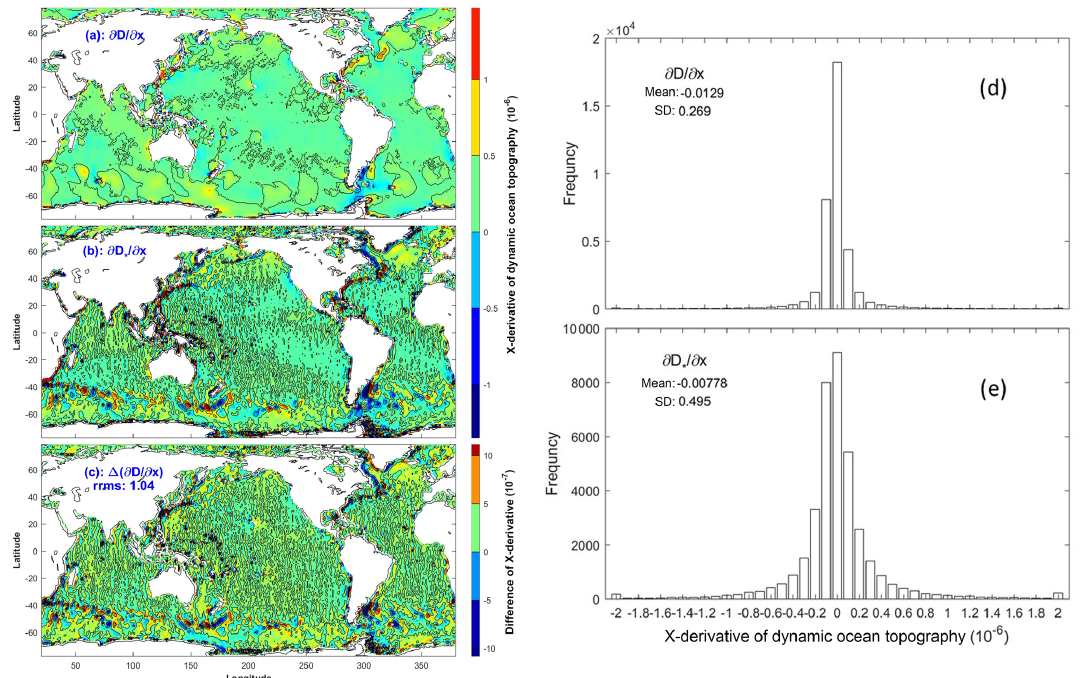
Figure 3. Derivatives in the x direction of (a) the first-type DOT (i.e., ∂D/∂x) , (b) the second-type MDOT (i.e., ∂D ∗ /∂x) , (c) the difference (cid:49)(∂D/∂x) = ∂D ∗ /∂x − ∂D/∂x , (d) histogram of global ∂D/∂x , and (e) histogram of global ∂D ∗ /∂x